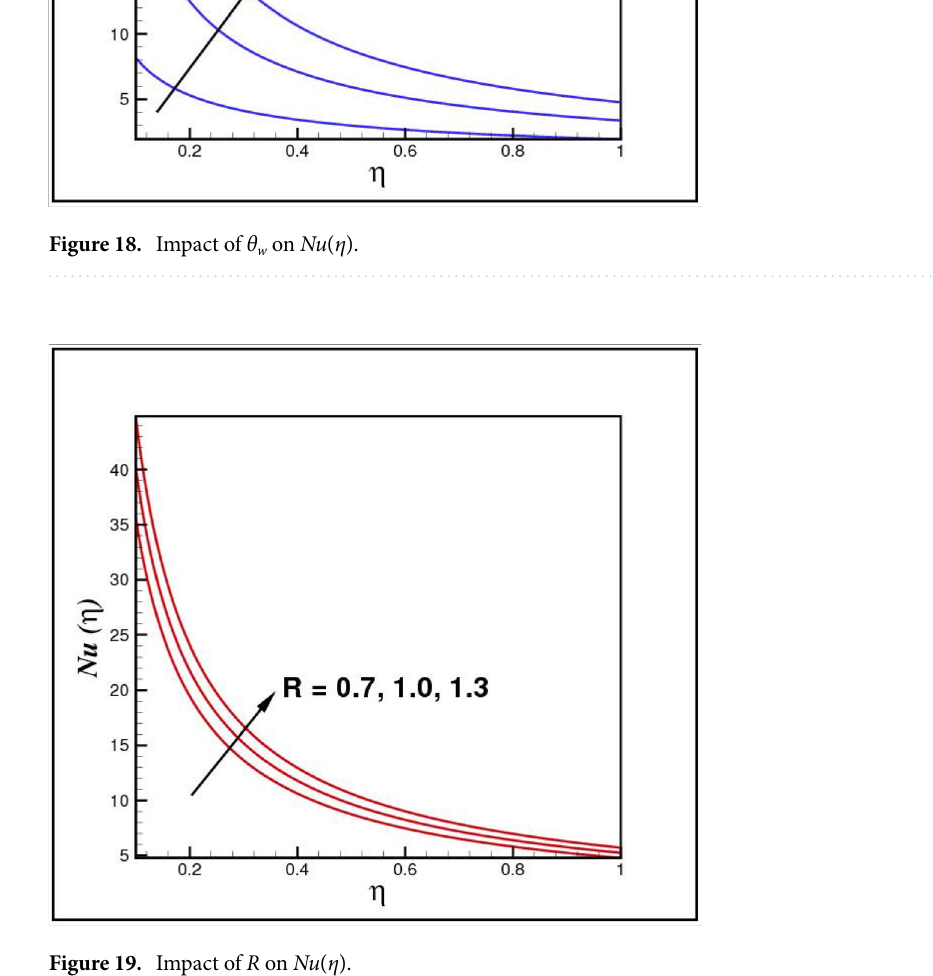
Figure 19. Impact of R on Nu ( η